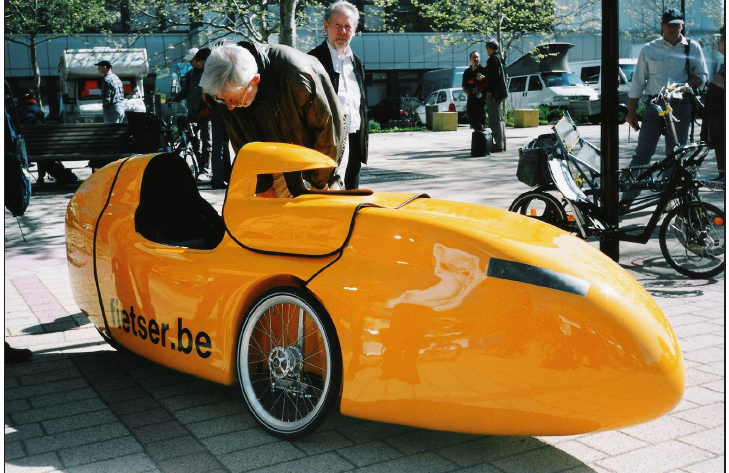
Figure 3: Velomobile (commuting